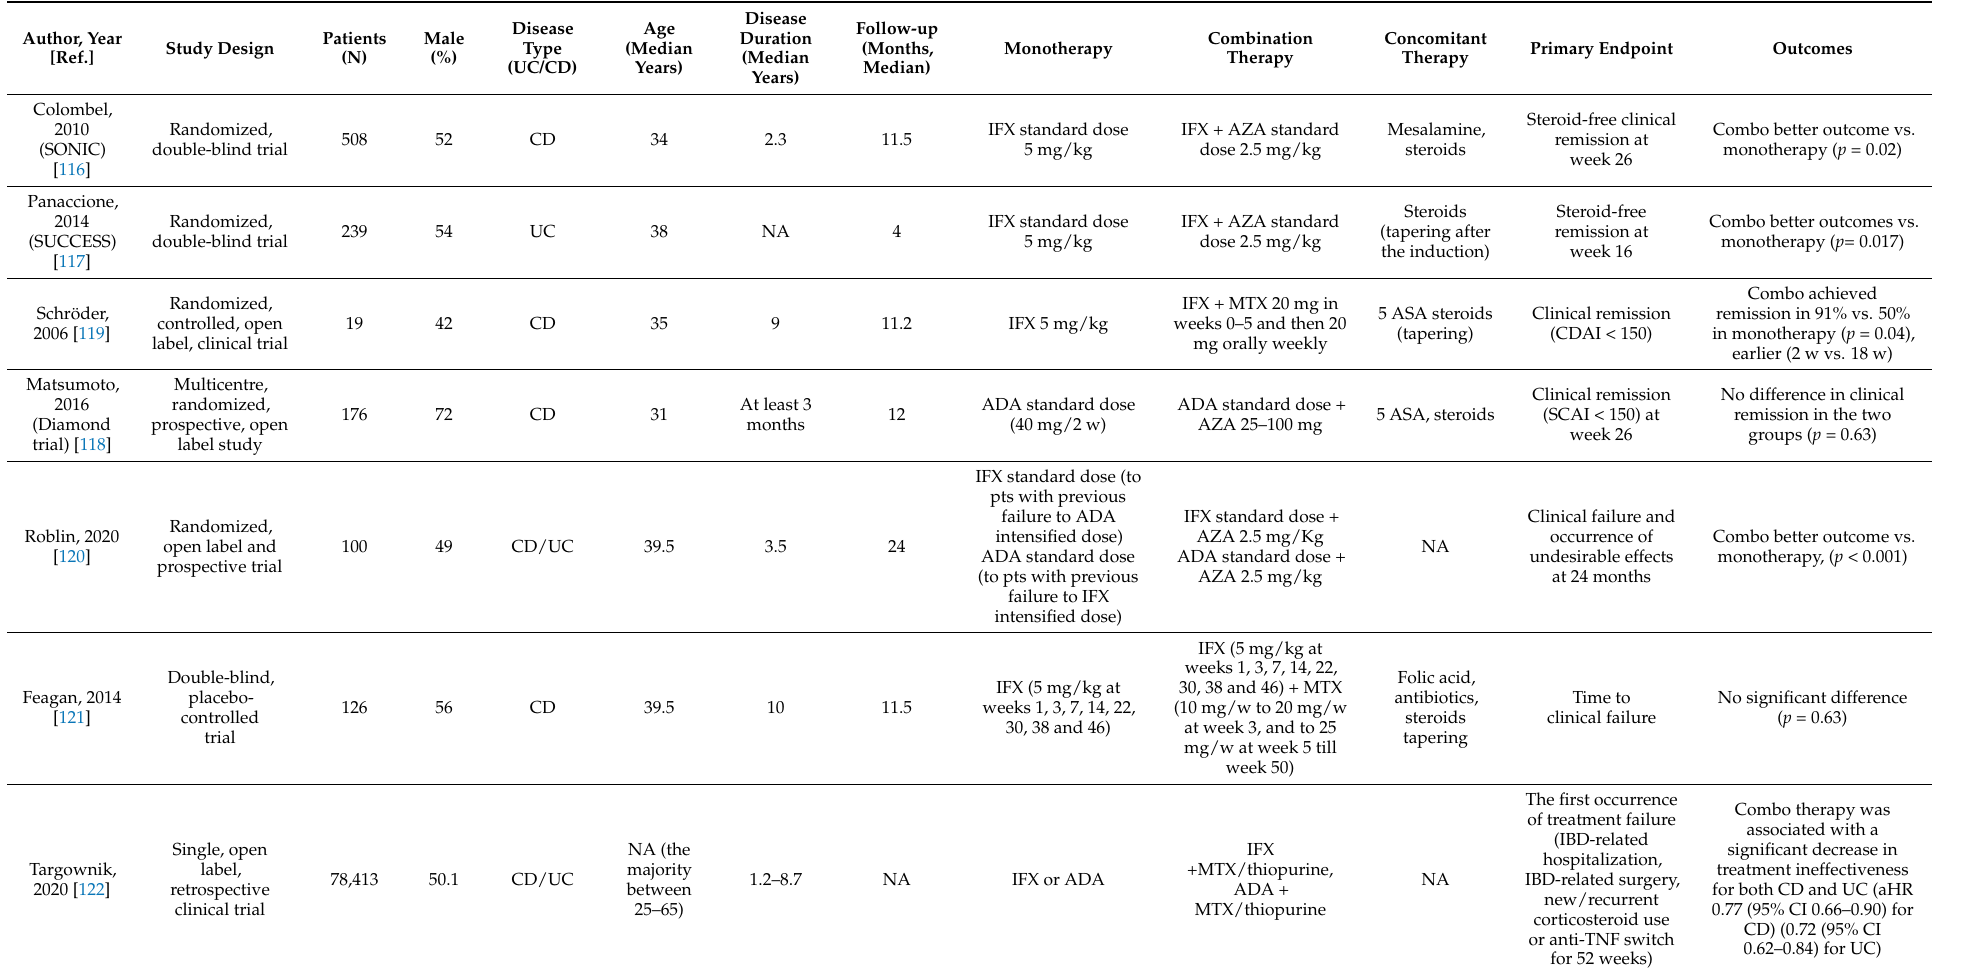
Table 4. Summary of the studies using combination therapy versus monotherapy in patients with